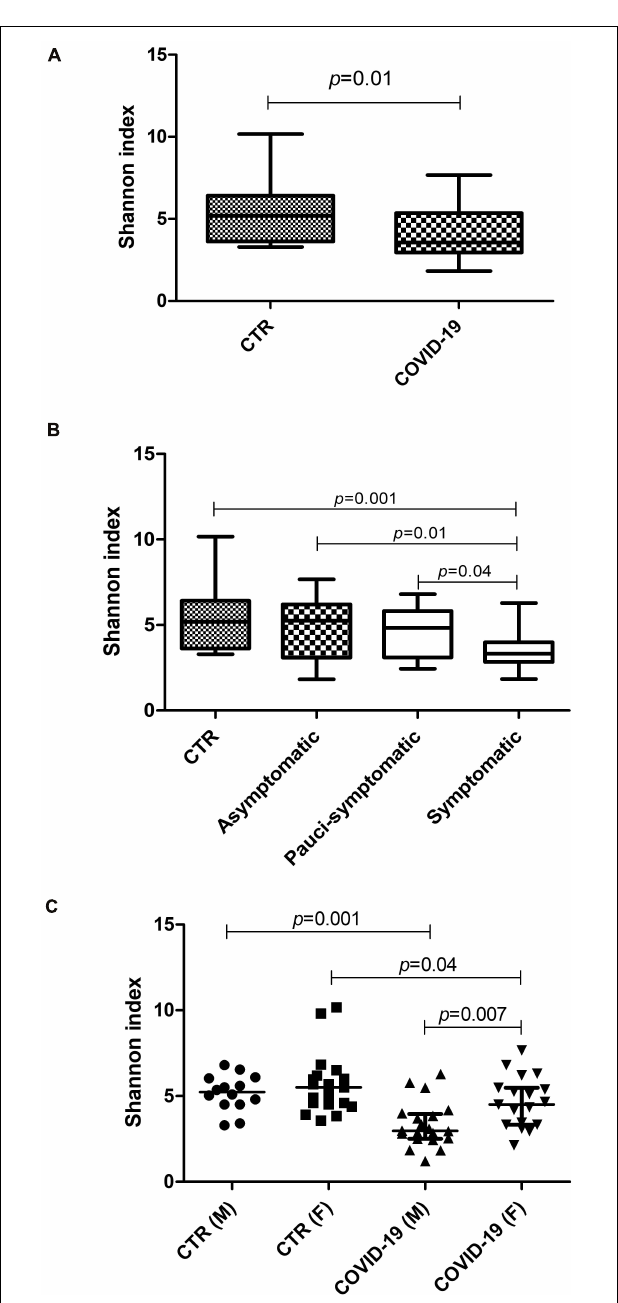
FIGURE 2 | Alpha-diversity values in the oral microbiomes of control and COVID-19 subjects. (A) Comparison between control and COVID-19 patients, expressed as median and range values. (B) Comparison between controls and COVID-19 asymptomatic, pauci-symptomatic, and symptomatic subjects; median and range values are shown. (C) Comparison between genders (M, male; F, female) in the control and COVID-19 groups; median values with interquartile range are shown for each